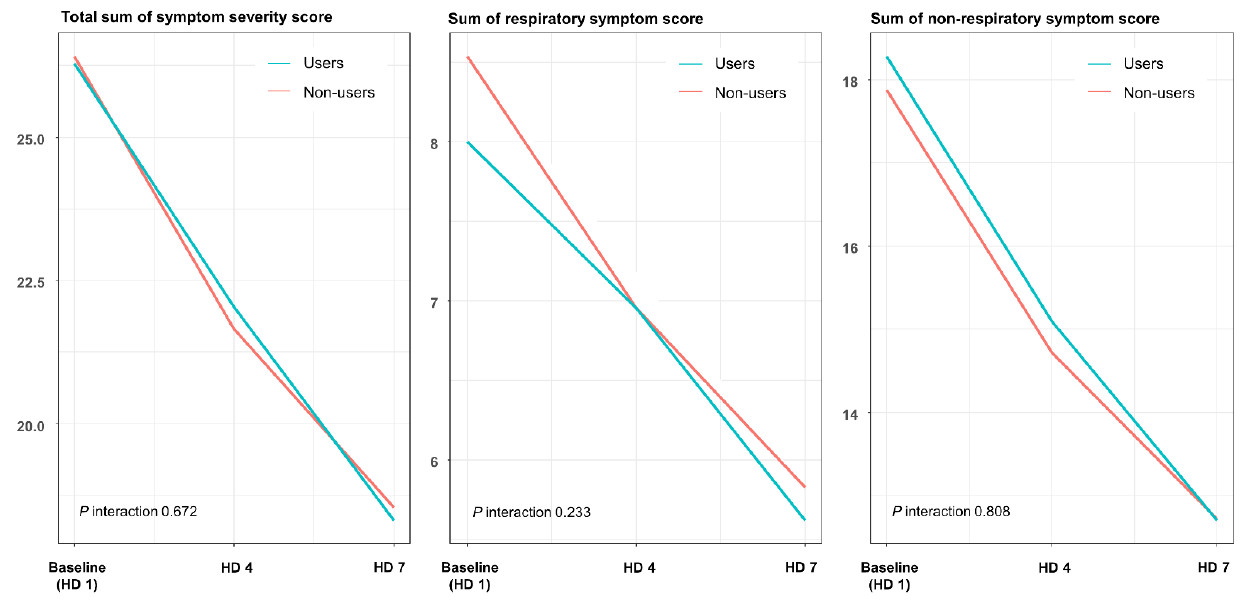
Figure 1. Estimated symptom severity scores of respiratory and non-respiratory symptoms according to the usage of regdanvimab using a linear mixed-effect model. HD = hospitalization day.